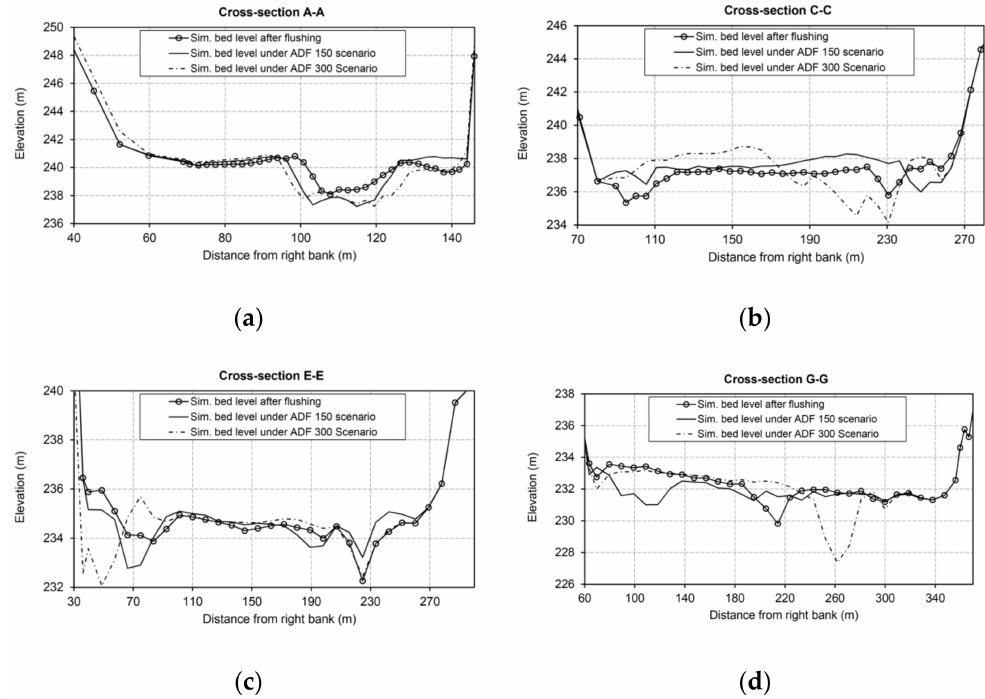
Figure 8. Simulated bed levels after flushing in the reference case and under the ADF 150 and ADF 300 scenarios at ( a ) cross-section A–A; ( b ) cross-section C–C; ( c ) cross-section E–E and ( d ) cross-section G–G. Locations of the cross sections can be found in Figure 1c; Sim. is an abbreviation for